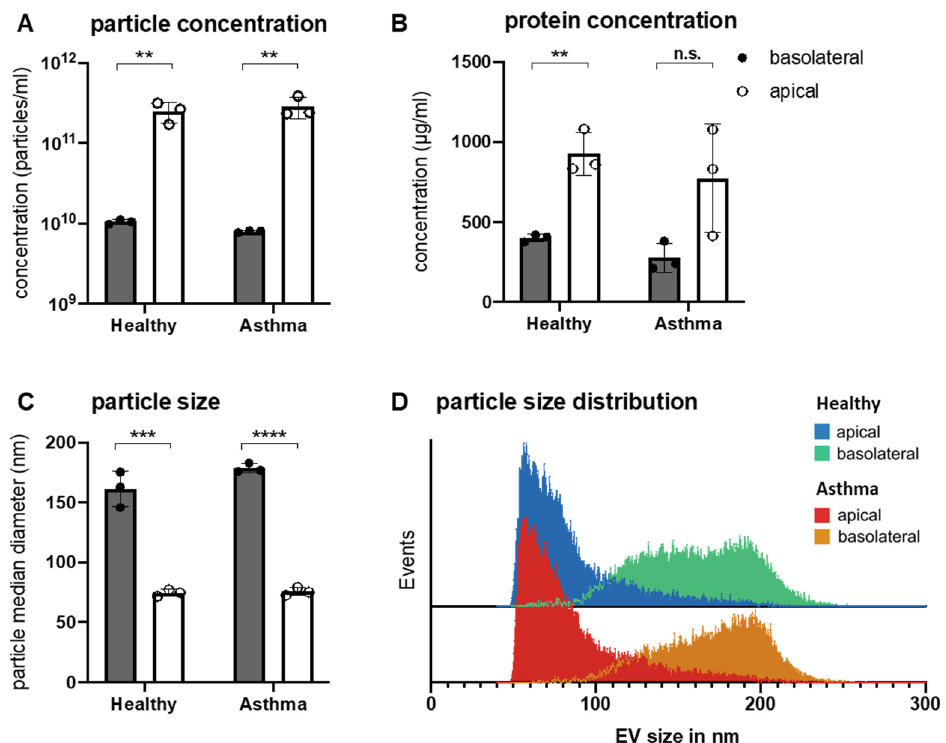
Figure 2. EV characteristics in apically and basolaterally secreted vesicles. ( A ), Particle concentration after EV isolation analyzed by NanoFCM. ( B ), Protein concentration in EV isolates measured by NanoDrop Protein A280. ( C ), Median particle diameter and ( D ) size distribution of EVs isolated from the apical or basolateral side of bronchial epithelial cell cultures from healthy and asthmatic subjects analyzed by NanoFCM. Bars represent mean ± SD; dots indicate individual samples. ** p < 0.01, *** p < 0.001, **** p < 0.0001. EV—extracellular vesicle; n.s.—not significant.